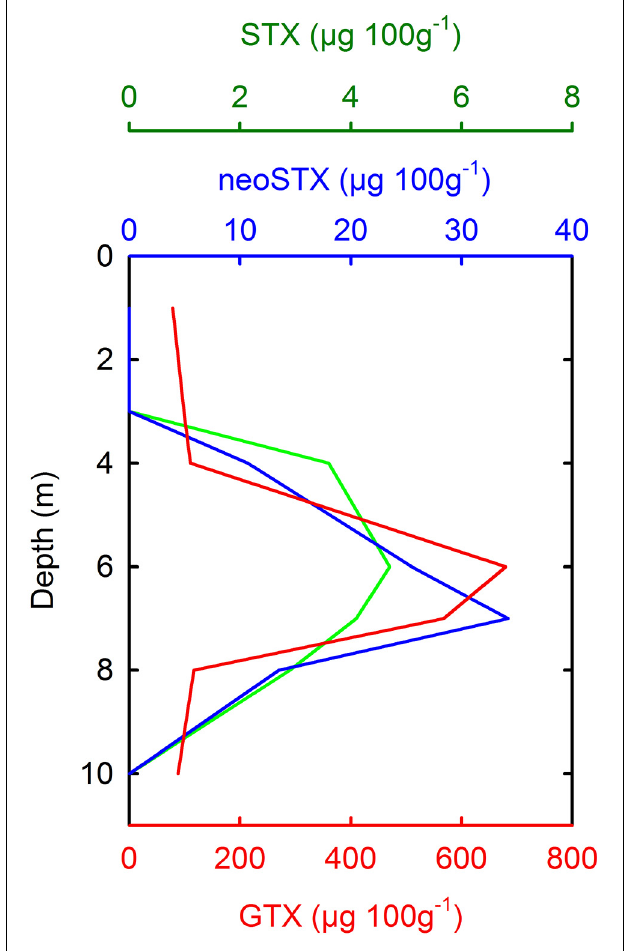
FIGURE 6 | Vertical stratification of PSP toxins in samples of mussel ( Mytilus chilensis ) tissue from Cailín Island, off Chiloé Island on April 24, 2002 (Data taken from García et al., 2004b). PSP toxins were associated with the presence of A. catenella (García et al., 2004b). M. chilensis were suspended from an aquaculture shellfish lantern at various depths, and the toxin contents therefore reflect the average position and toxicity of A. catenella cells in the water column. GTXs, Gonyautoxins; neoSTX, neoSaxitoxin; STX =